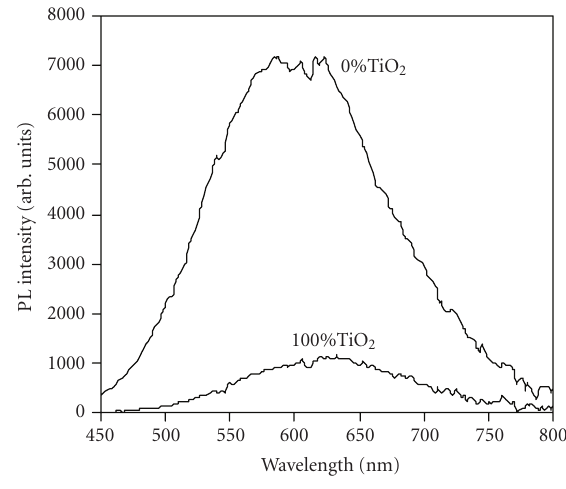
Figure 7: Photoluminescence of PTEBS/TiO 2